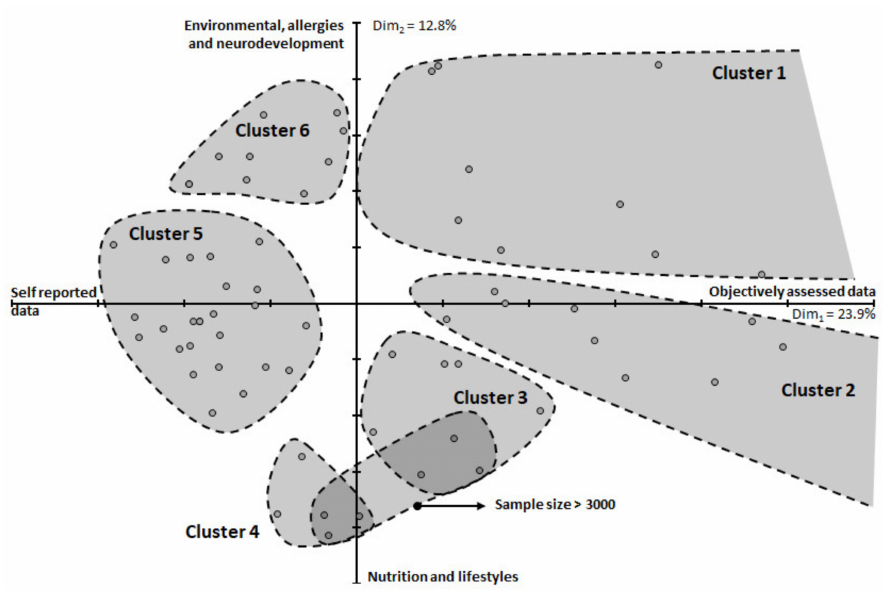
Figure 4. Clustering of the pregnancy cohort according to multiple correspondence analysis applied to research focuses. Grey areas represent results of hierarchical clusters and identify groups of homogeneous studies.